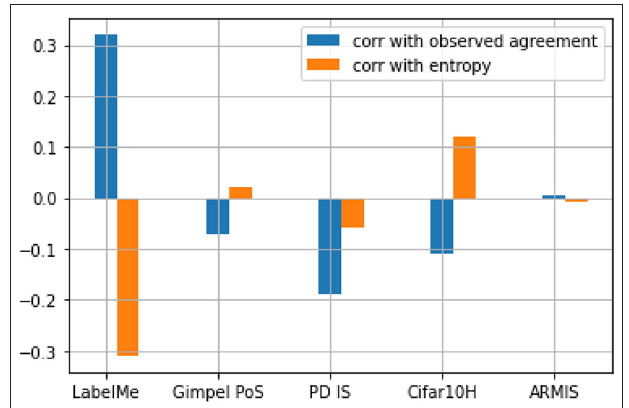
FIGURE 3 | Graph showing the correlation of T i with observed agreement and